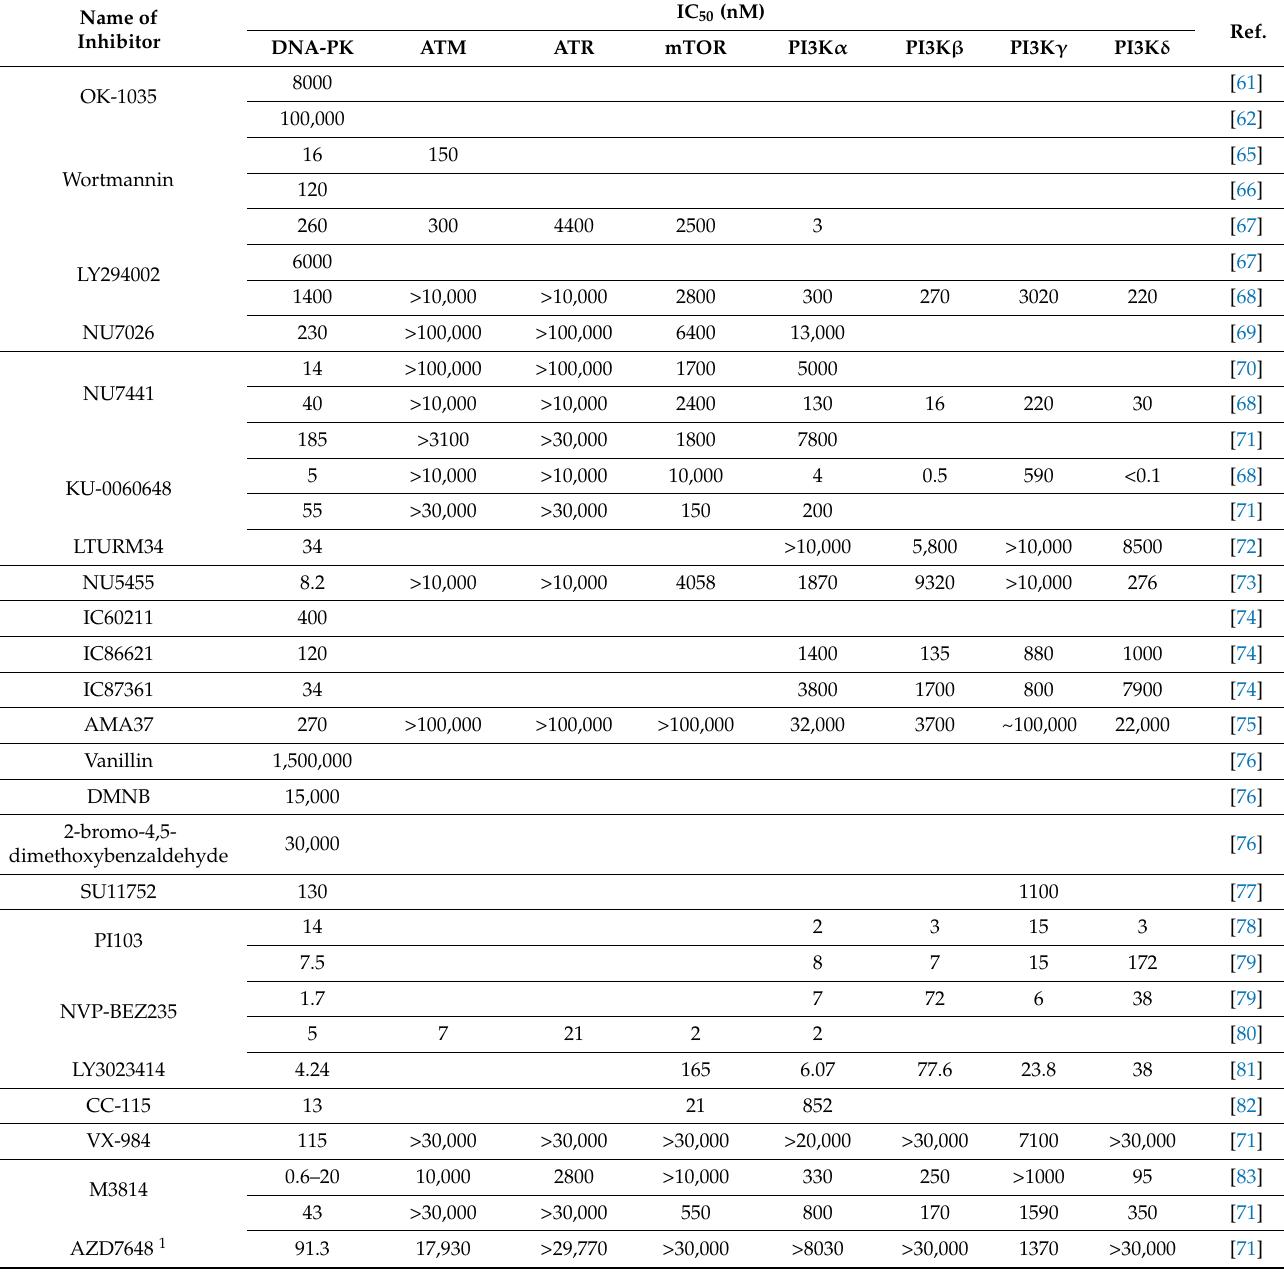
Table 2. DNA-PK inhibitors with IC 50 for PIKKs and